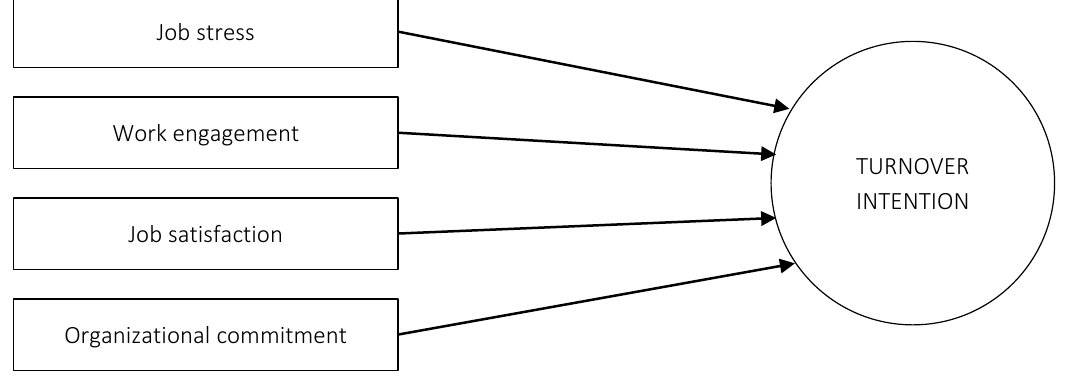
Figure 1. Research